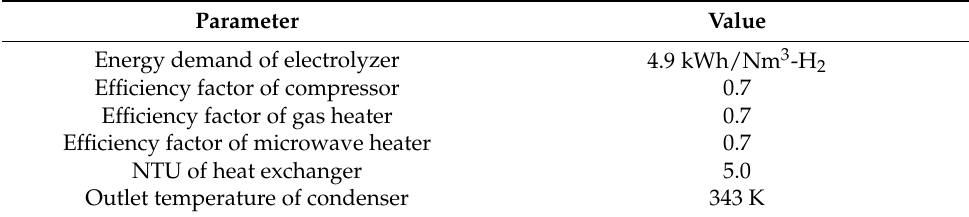
Table 3. Parameters for assessment of the energy